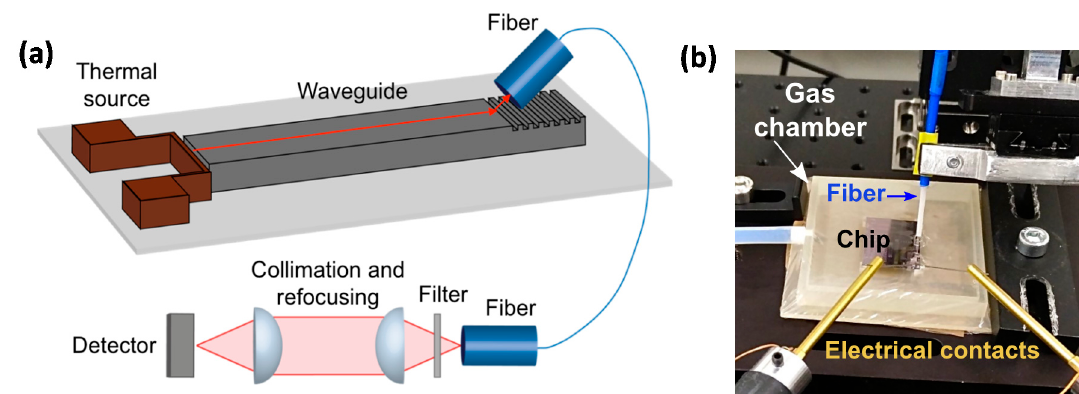
Figure 1. ( a ) Schematic view of the measured structure and of the measurement setup; ( b ) Experimental realization of the gas cell, with access for the electrical contacts and the